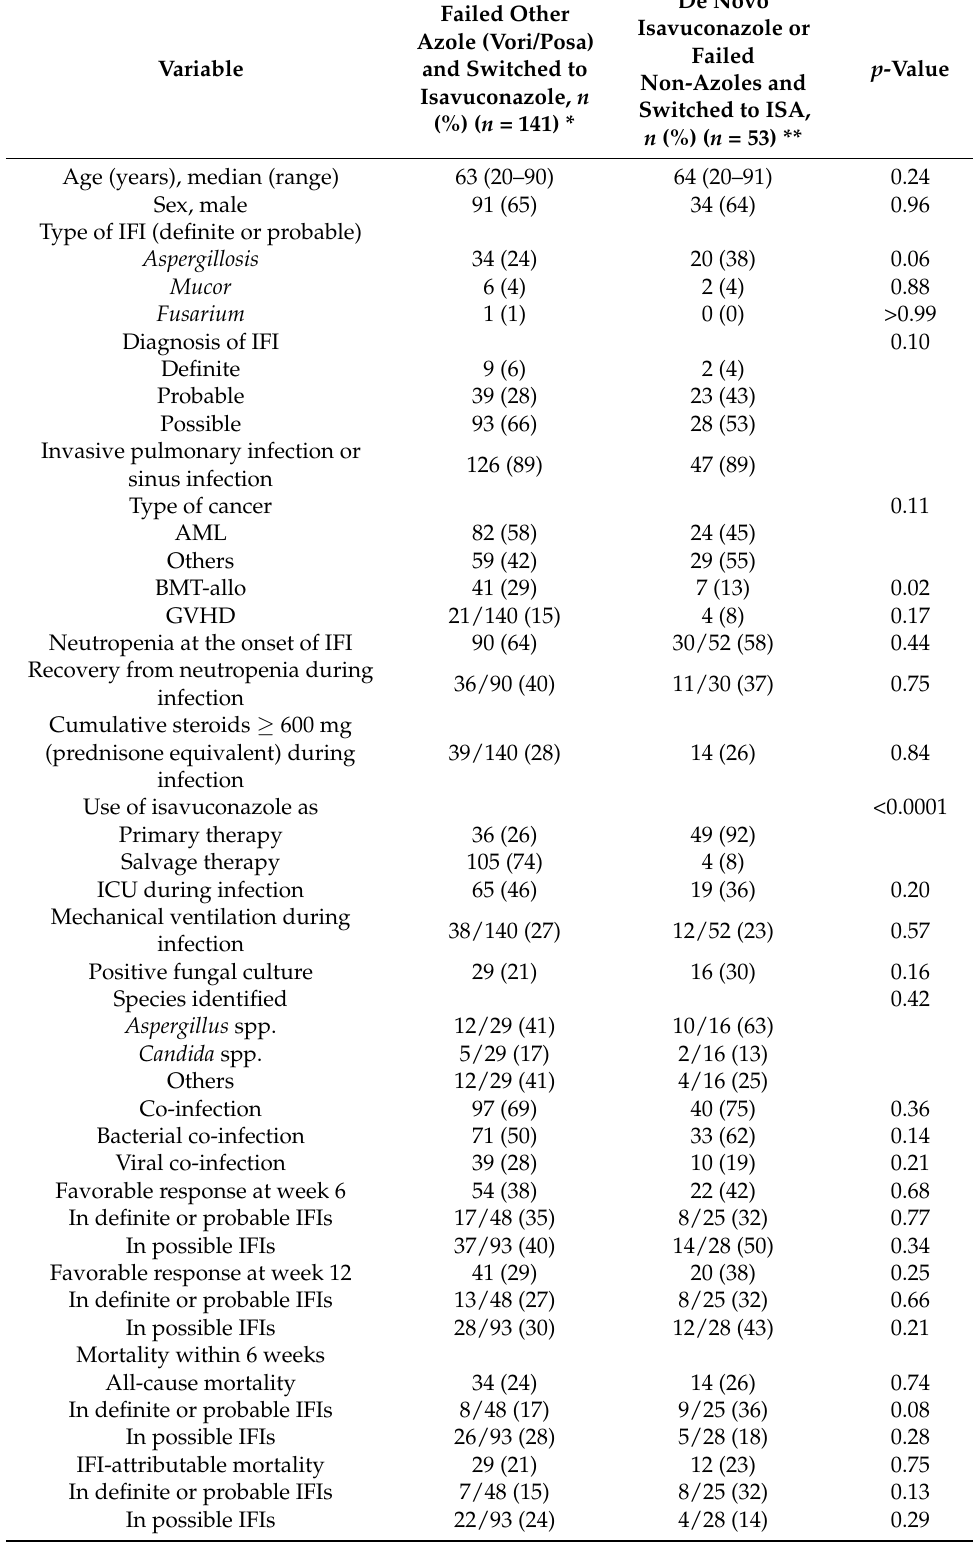
Table 3. Comparison of different treatment